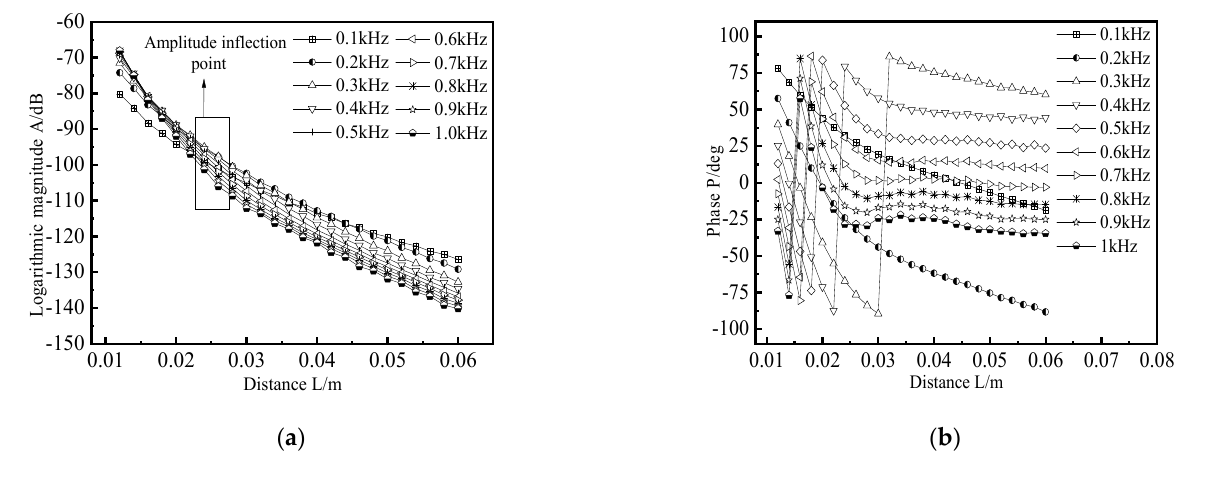
Figure 11. Amplitude–distance curve and phase–distance curve under different excitation frequencies. ( a ) Amplitude–distance curve; ( b ) Phase–distance curve.